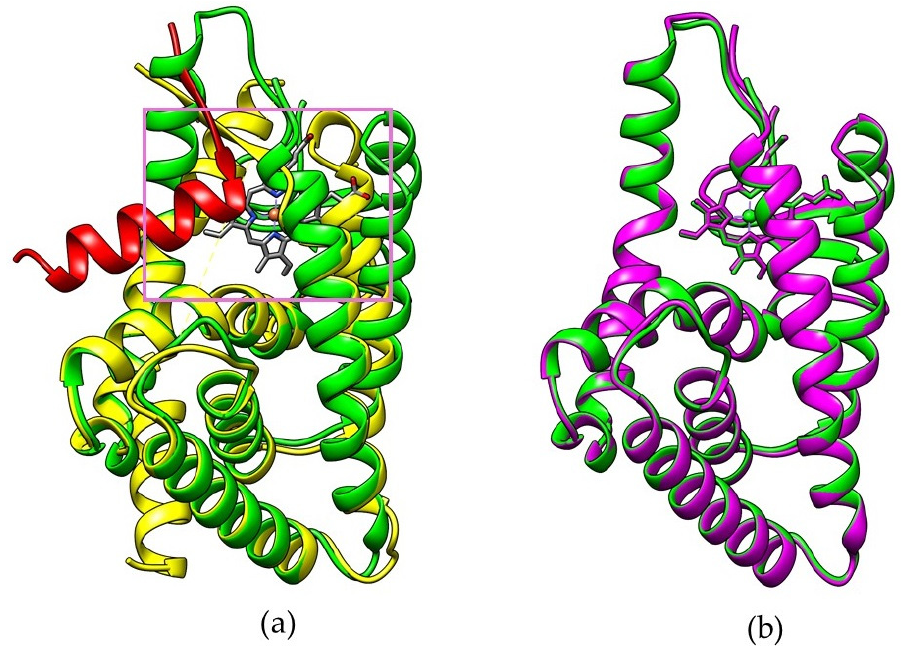
Figure 1. ( a ) Overlay visualization of apo-structure REV-ERB β (yellow) with bound NCoR (red) and REV-ERB β in complex form with Heme (green). ( b ) Visualization of REV-ERB β in complex form with Heme (green) and with CoPP (purple).